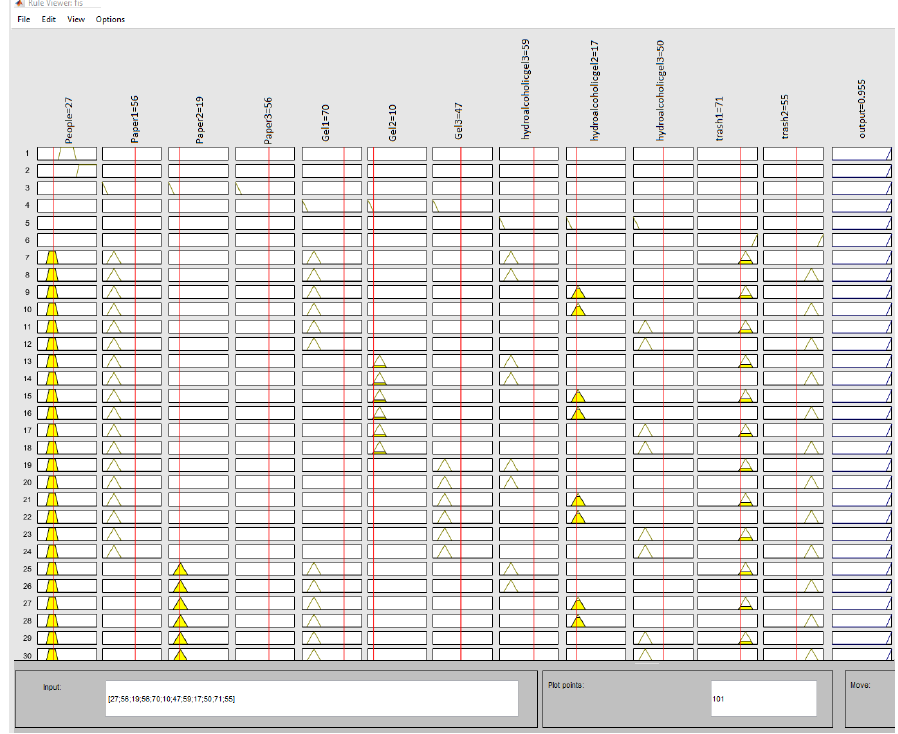
Figure 16. Mandami control